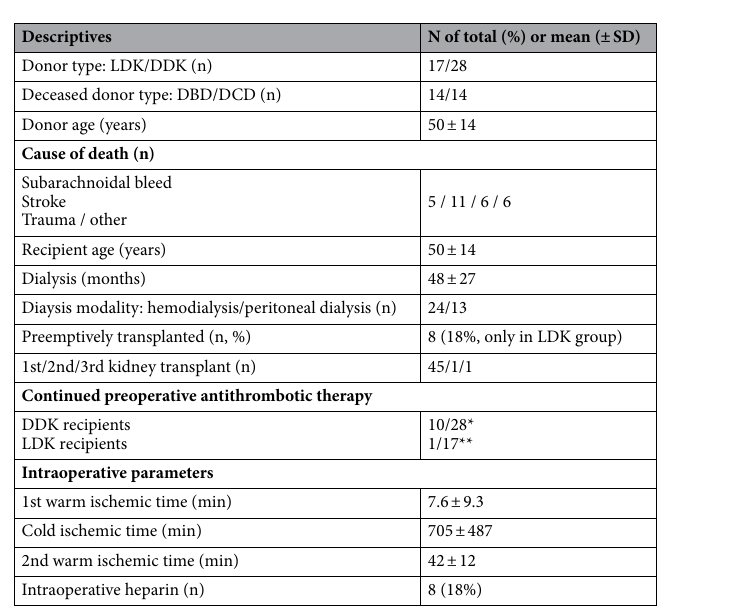
Table 1. Baseline characteristics and intraoperative variables. *carbasalate calcium, n = 9 and clopidogrel, n = 1 **carbasalate calcium, n = 1